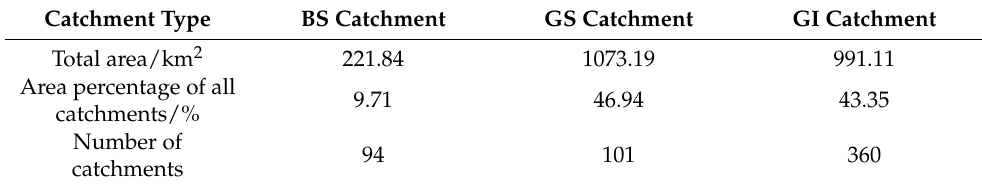
Table 3. Total area and percentage of each catchment